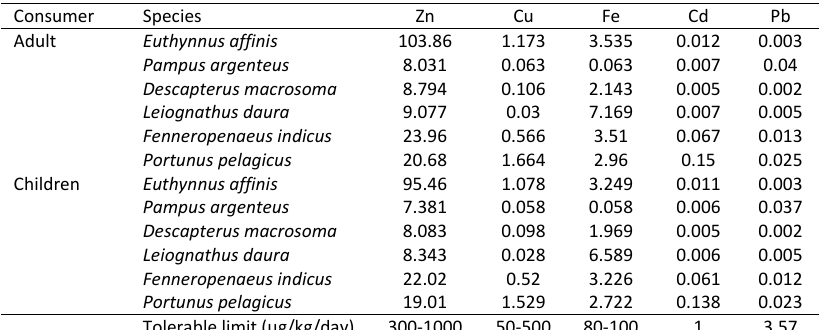
Table 5: Estimated daily intake (µg/kg/day) of heavy metals from fish Table 5. Estimated daily intake (µg/kg/day) of heavy metals from